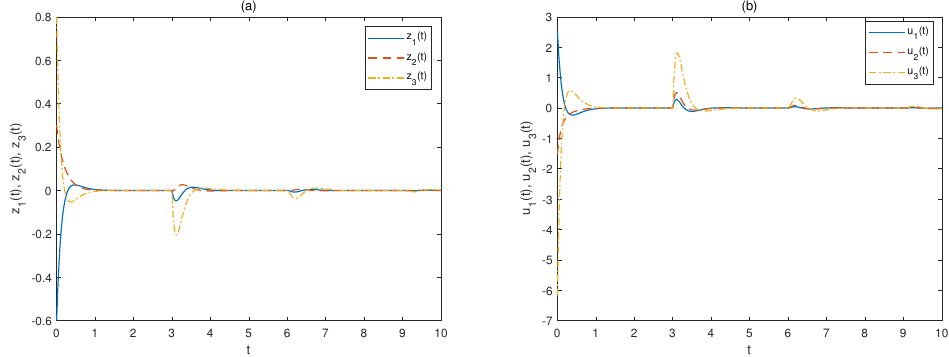
Figure 8. Trajectories of ( a ): z ( t ) ; ( b ): u ( t ) of Example 2 based on optimization scheme